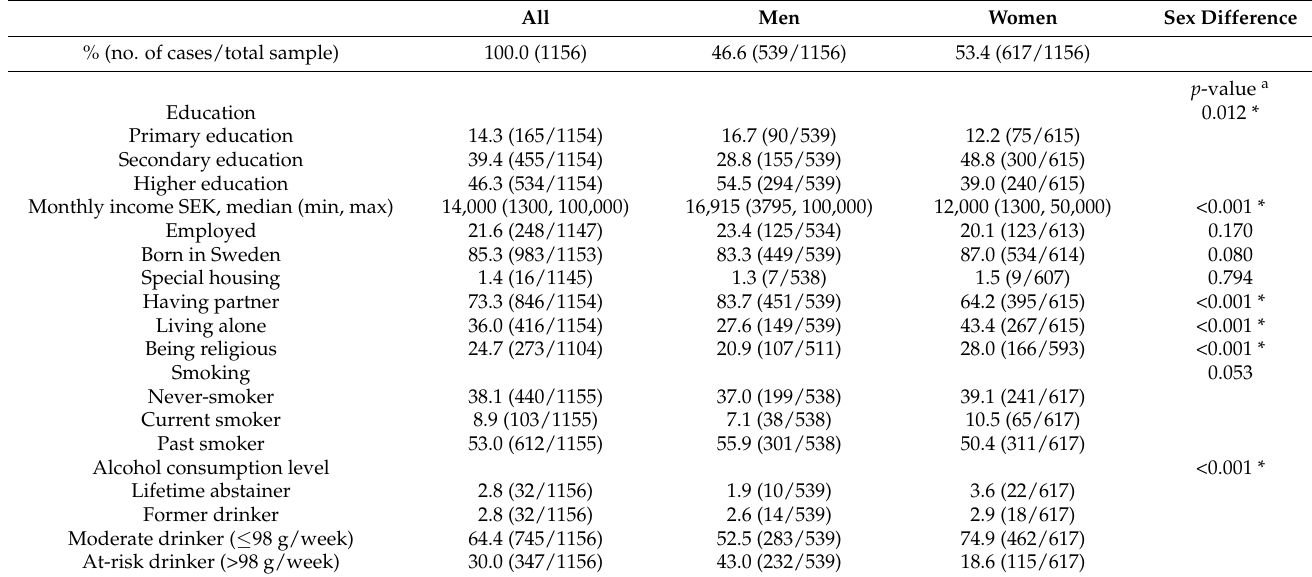
Table 3. Sample characteristics, 70-year-olds born in 1944 (examined 2014–16) stratified by sex ( n = 1156). All Men Women Sex